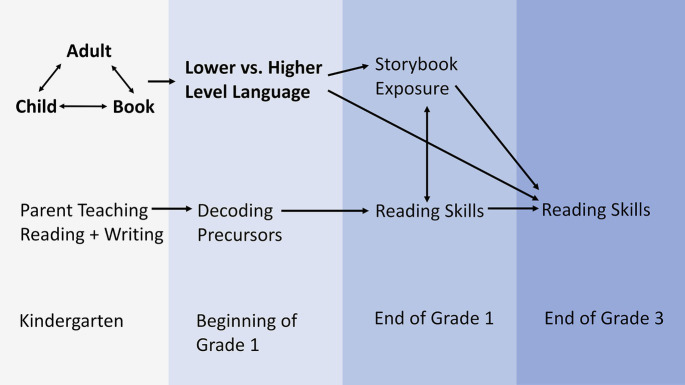
Modified Home Literacy Model with shared reading triad (adapted from Sénéchal and LeFevre, 2002; van Kleeck, 2003; Fletcher and Reese, 2005). © 2002 by the Society for Research in Child Development, Inc. Adapted with permission.